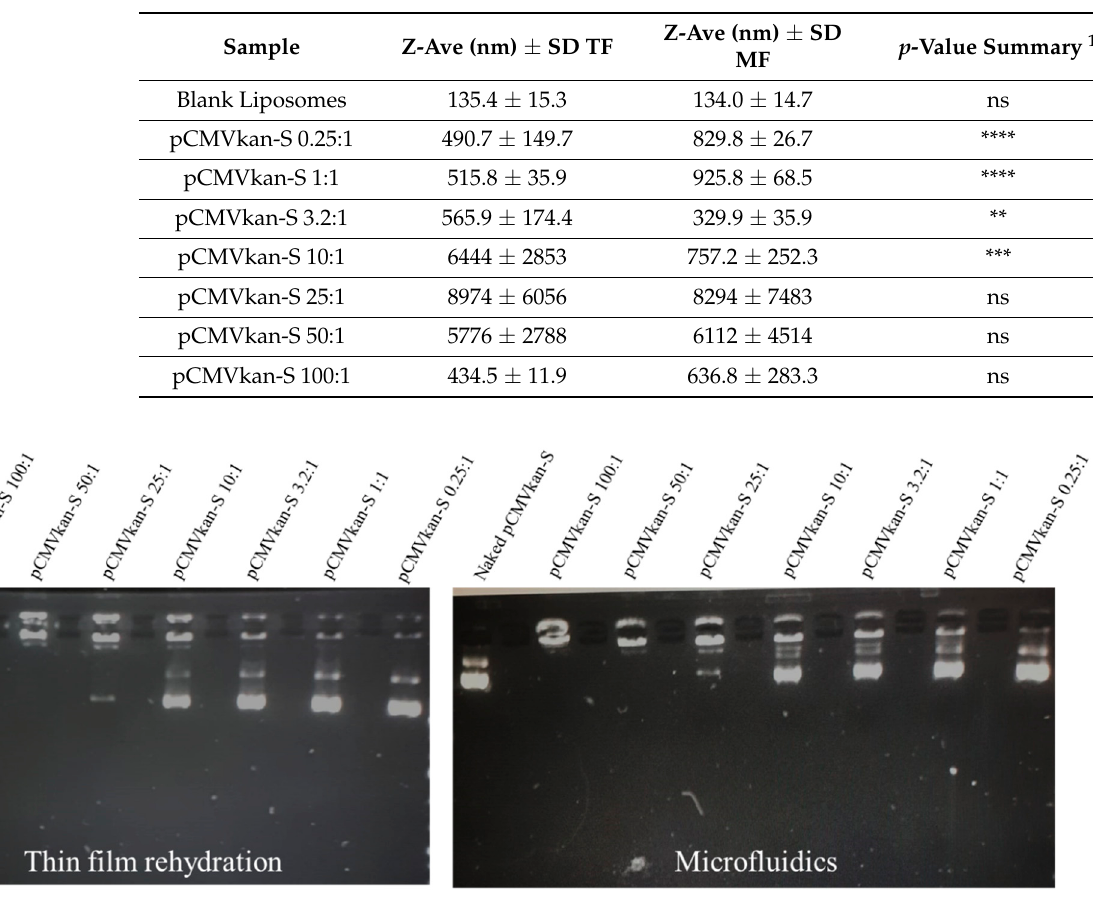
Table 1. Lipoplex characteristics and summary of statistical analysis between same N/P ratios formulated with MF vs. TF particles. 1 The test performed is an unpaired Welch’s t -test. **** indicate p < 0.0001, *** p < 0.001, ** p < 0.01, ns shows non-significance.